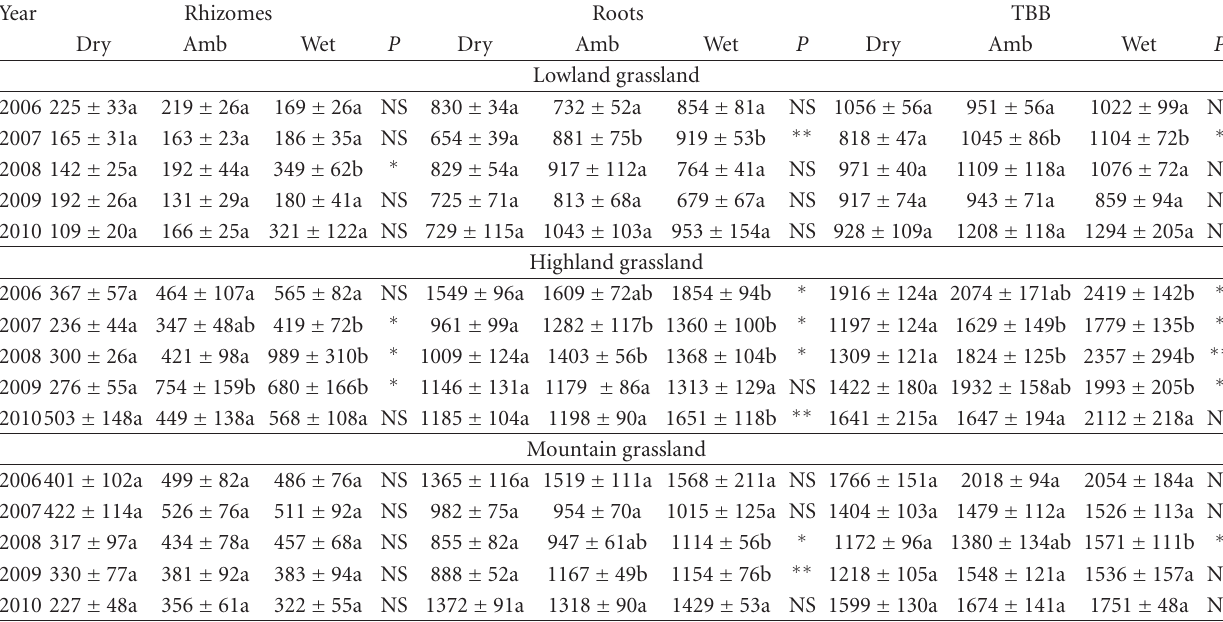
Table 5: Mean values ( ± SE) of dry mass of rhizomes, roots, and total below-ground biomass (TBB) under di ff erent amounts of precipitation (dry, ambient and wet treatments) recorded in five years (2006–2010): results of one-way ANOVA analysis (NS: not significant, ∗ P < 0 . 05, ∗∗ P < 0 . 01, ∗∗∗ P < 0 . 001). Di ff erent letters denote significantly di ff erent values for rhizomes, roots and total separately (Tukey HSD test ( P < 0 . 05) after ANOVA).